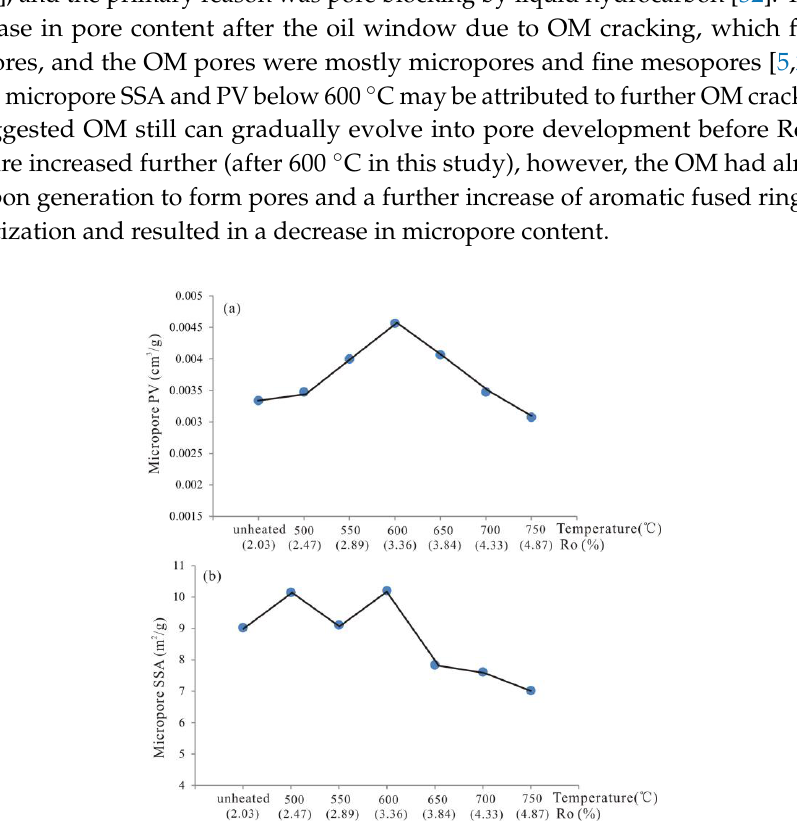
Figure 1. Low–pressure CO 2 adsorption isotherms of the shale samples at different temperatures.